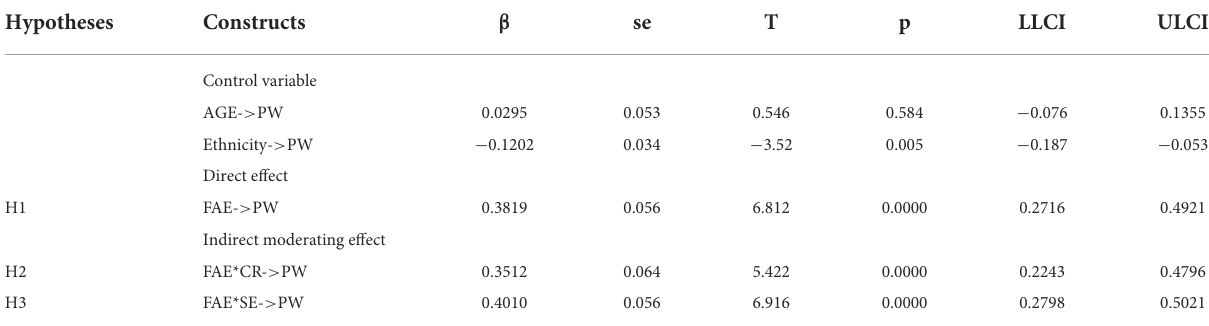
TABLE 4 Regression